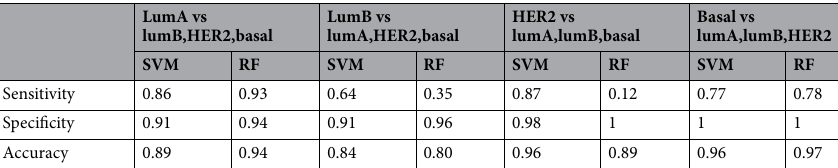
Table 5. Performance of classification Support Vector Machine (SVM) and Random Forest (RF) using subtype-specific interactions (sensitivity, specificity and